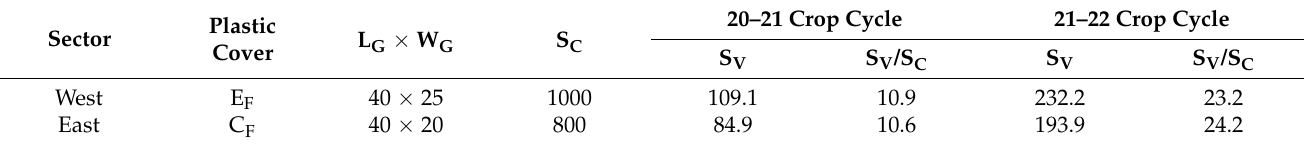
Table 1. Characteristics of the two sectors of the experimental greenhouse. L G , length [m]; W G ,